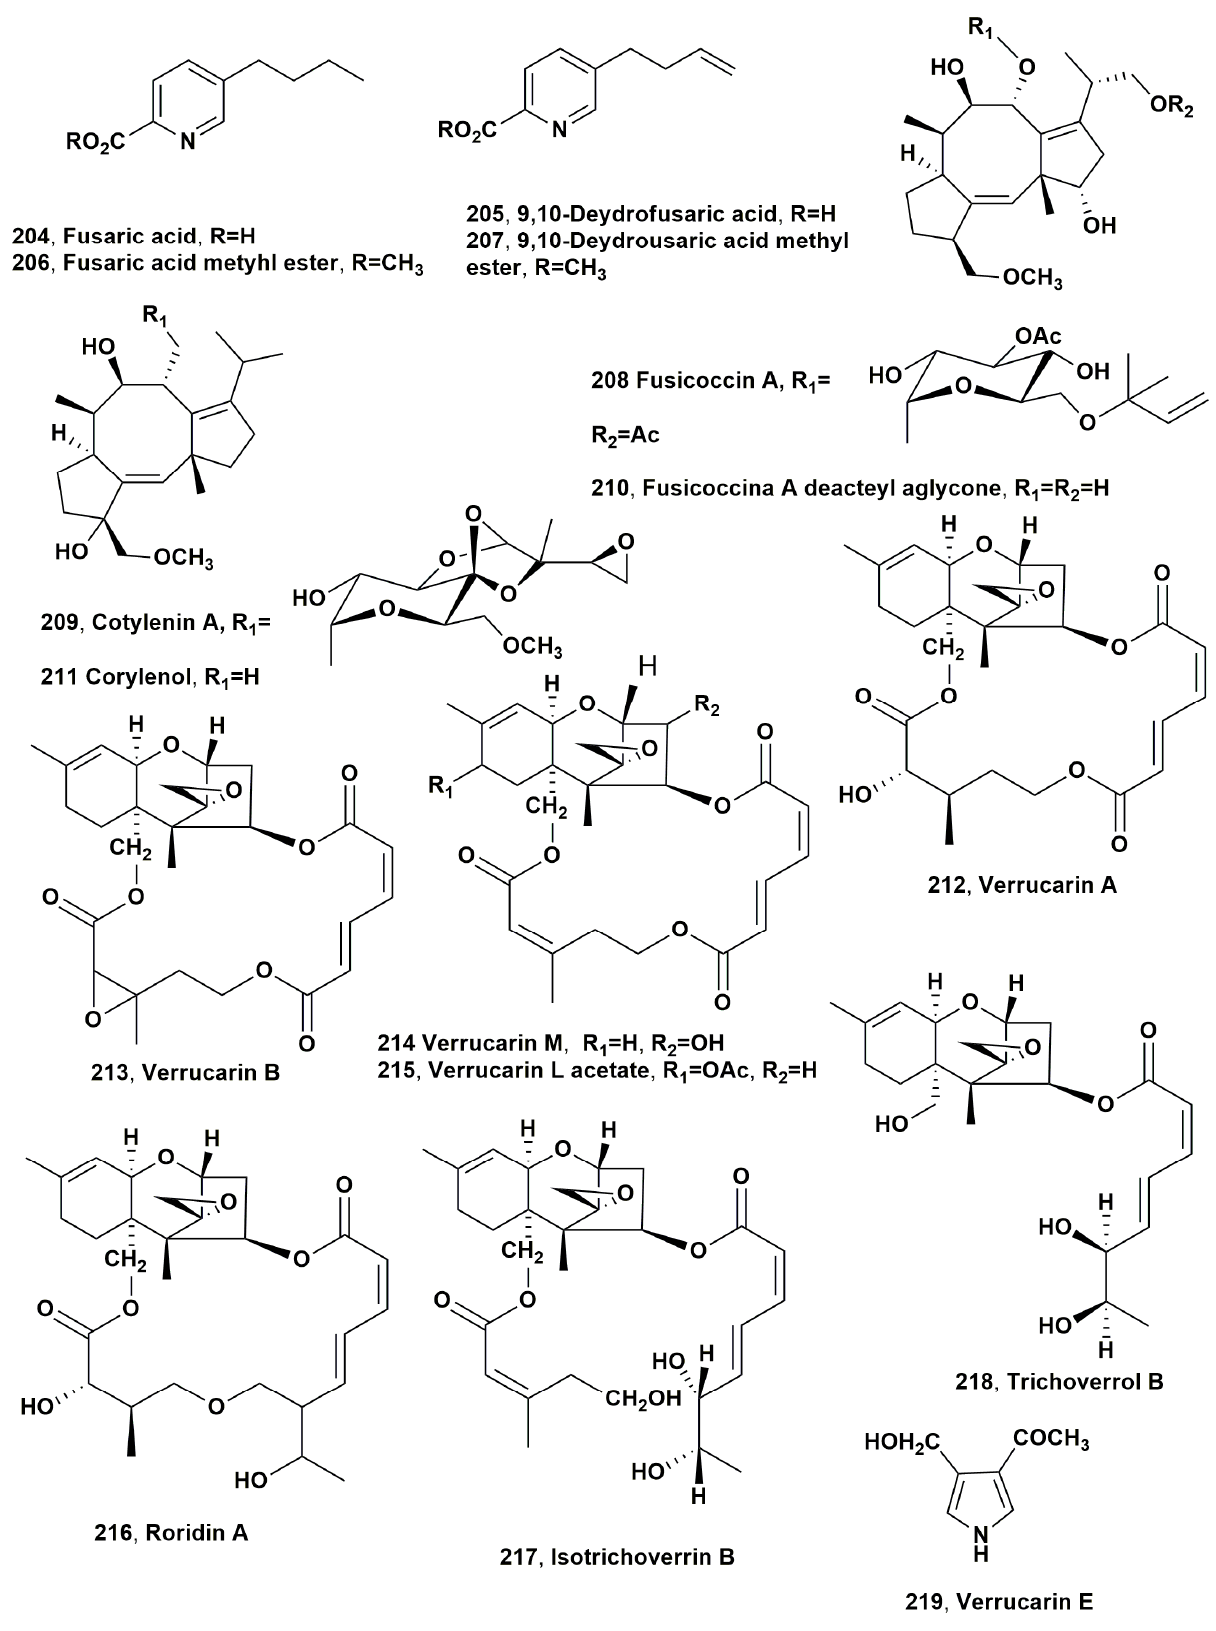
Figure 9. Metabolites produced by Fusarium nygamai ( 204 – 207 ), Phomopsis amygdali ( 208 and 210 ), Cladosporium sp. ( 209 and 211 ) Myrothecium verrucaria ( 212 – 219 ).